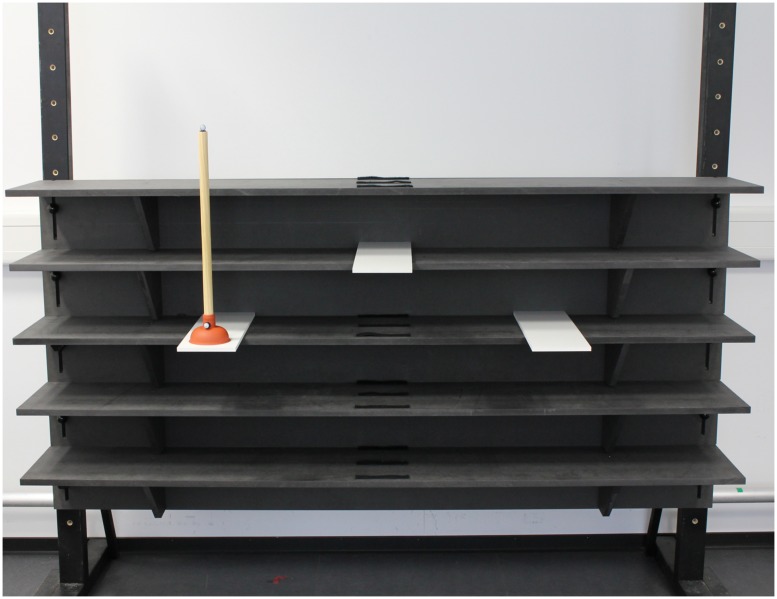
Experimental setup.